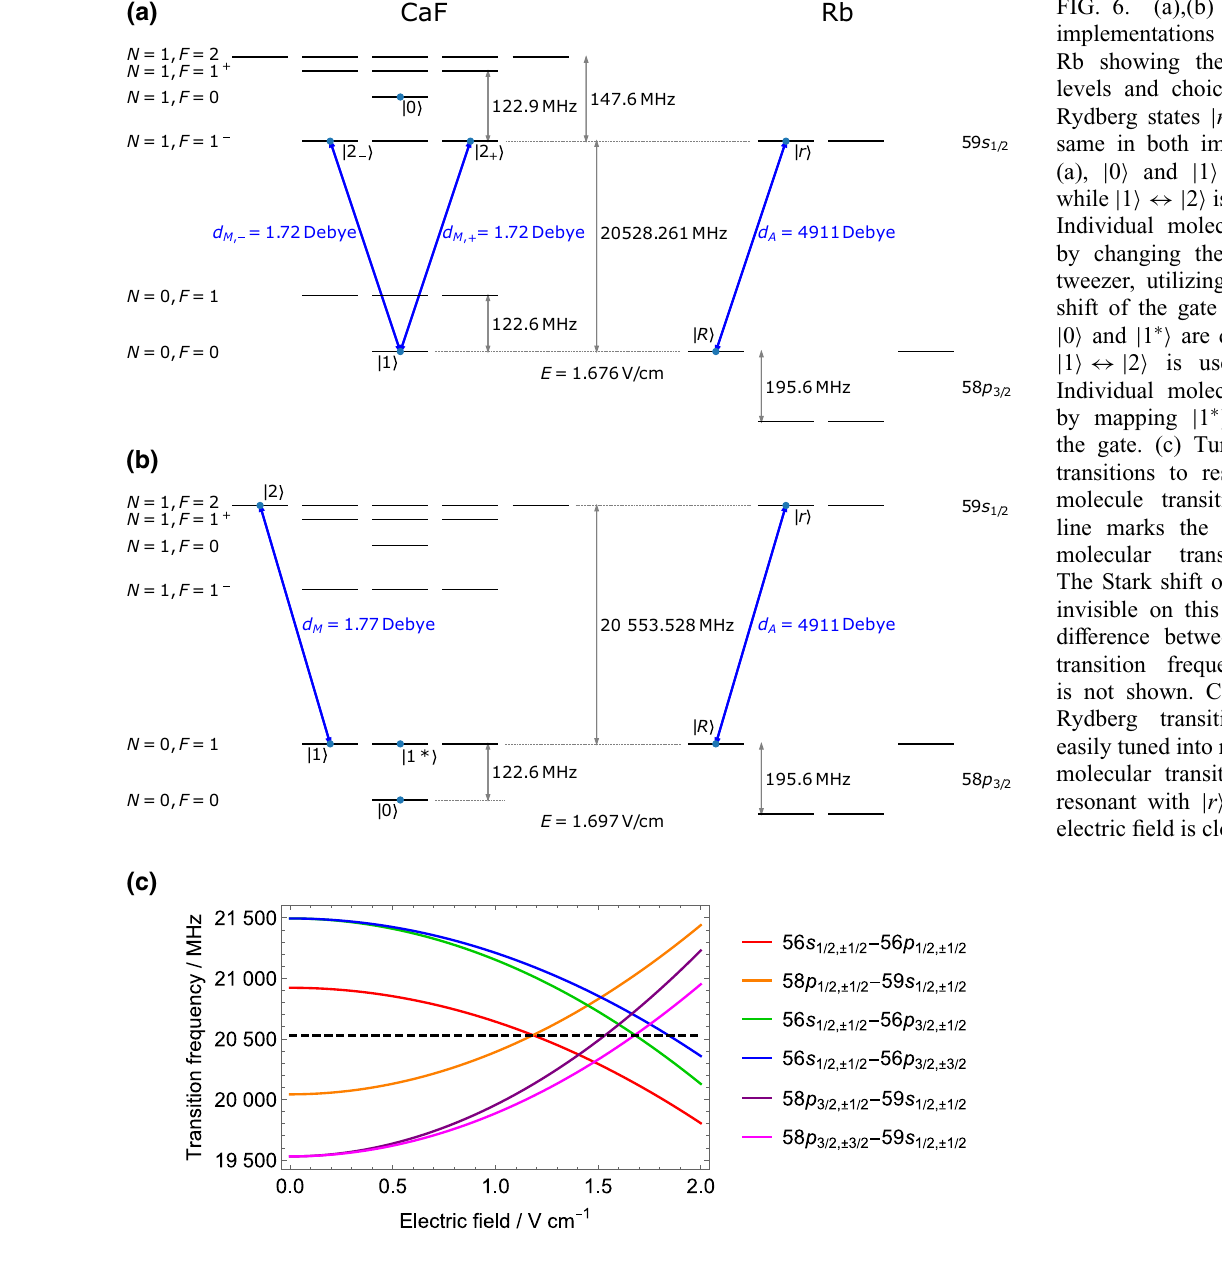
implementations using CaF and Rb showing the relevant energy levels and choices of states. The Rydberg states | r (cid:2) and | R (cid:2) are the same in both implementations.